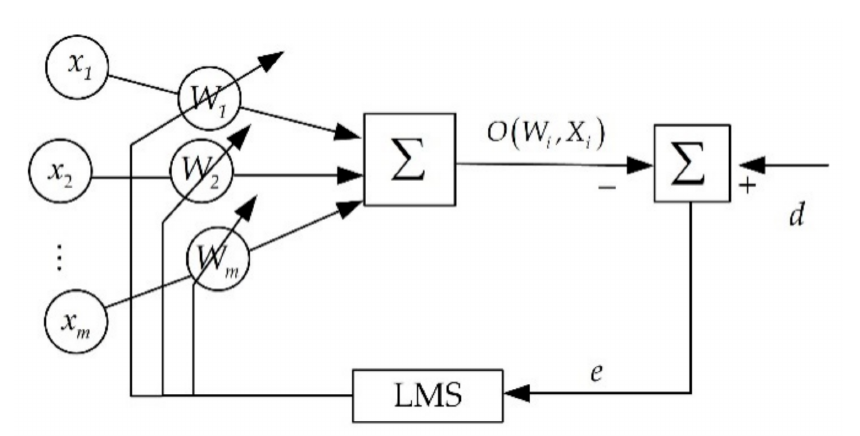
Figure A1. Block diagram of Adaline NN